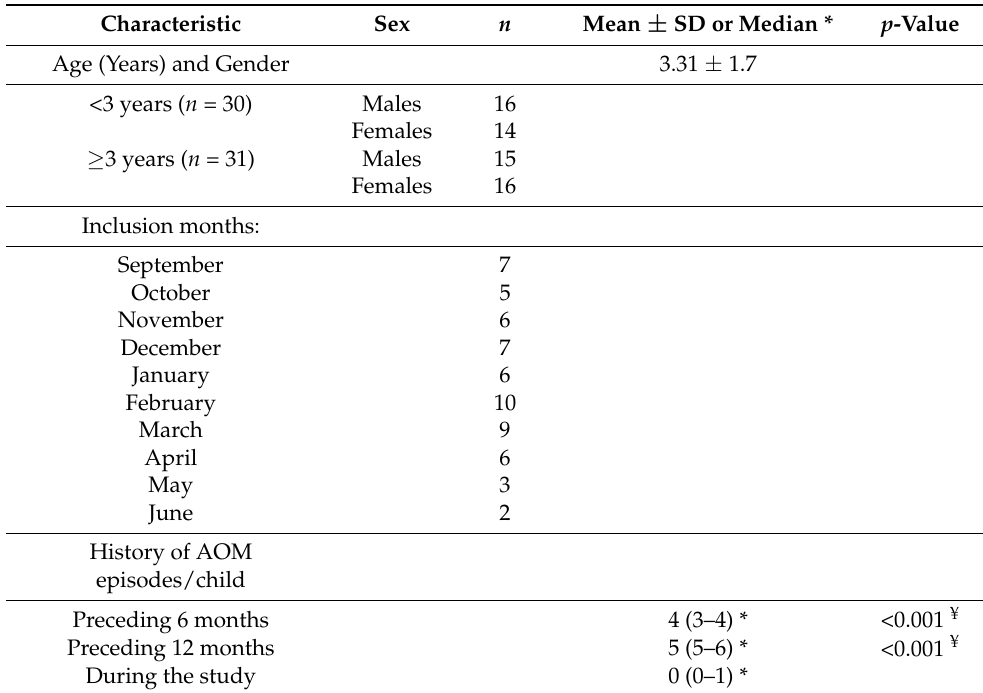
Table 4. Main demographic characteristics of the infants and children recruited in the pilot trial ( n = 61), and main outcomes of the study.